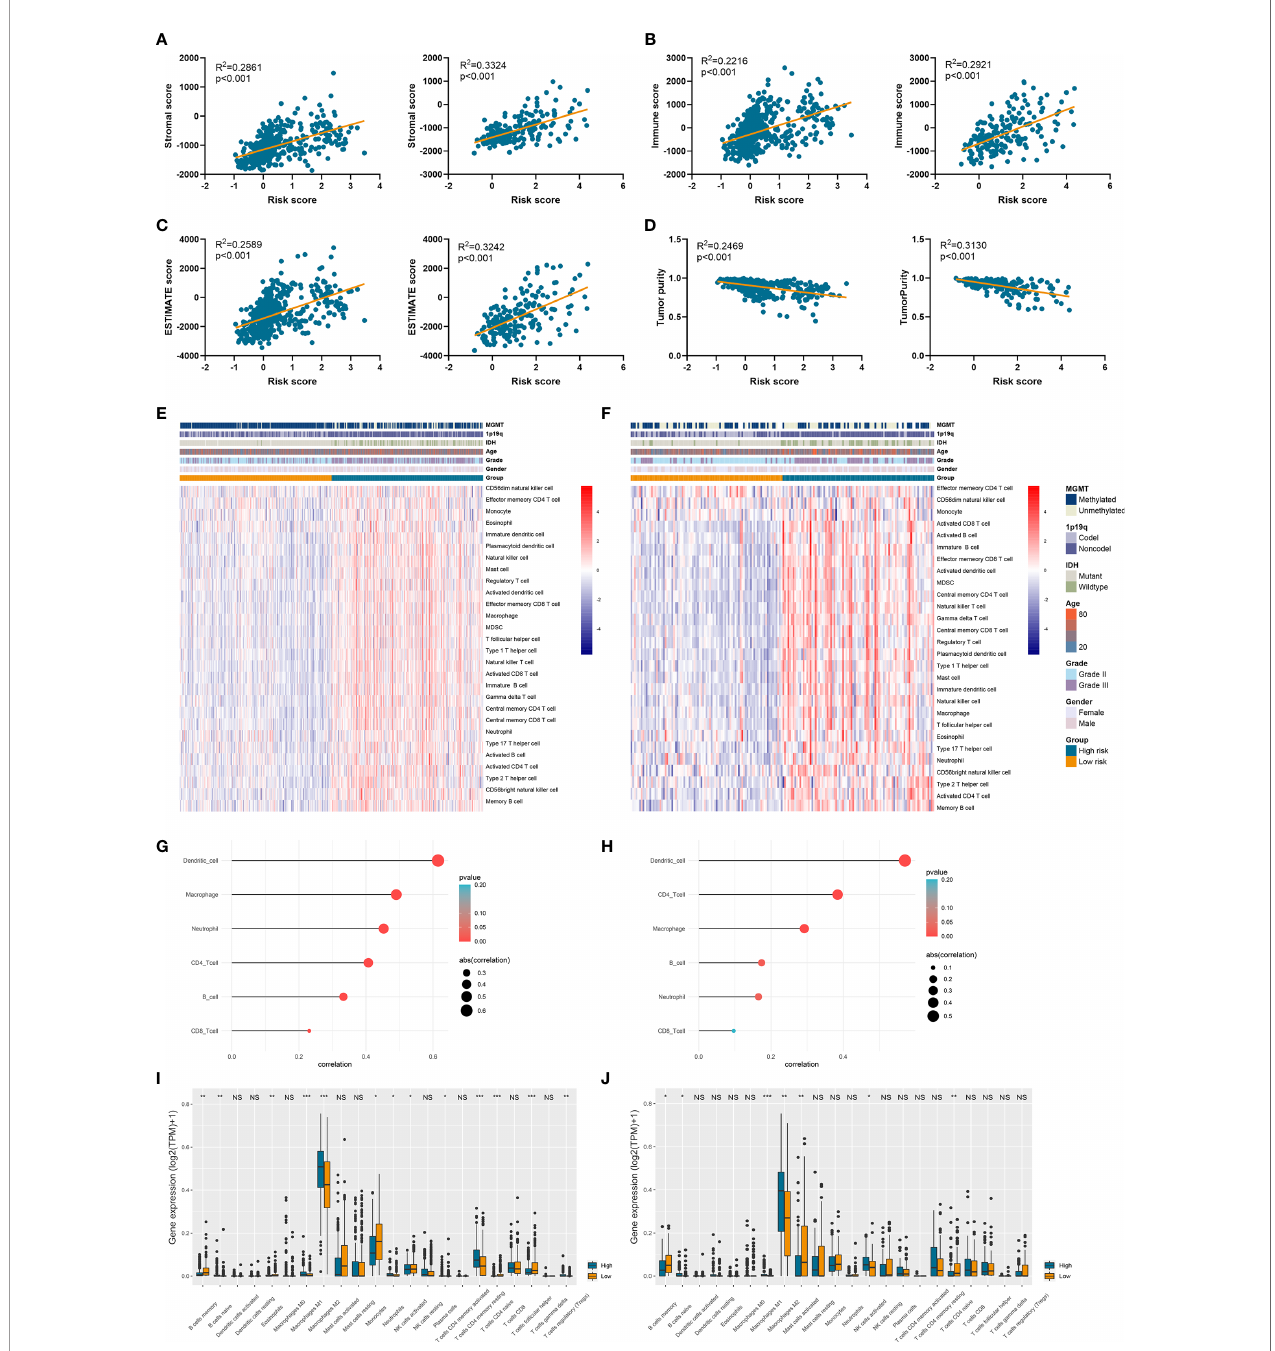
FIGURE 6 | Risk signature was associated with tumor purity and immune in fi ltration. (A – D) The association between risk score and stromal score (A) , immune score (B) , ESTIMATE score (C) , and tumor purity (D) . (E, F) The abundance of 28 immune cells estimated by ssGSEA algorithm in high-risk and low-risk groups in TCGA (E) and CGGA (F) datasets. (G, H) The correlation between risk score and six immune cells estimated by TIMER algorithm in TCGA (G) and CGGA (H) datasets. (I, J) The abundance of 22 immune cells estimated by CIBERSORT algorithm in high-risk and low-risk groups in TCGA (I) and CGGA (J) datasets. *p < 0.05, **p < 0.01, ***p < 0.001, ns, no signi fi